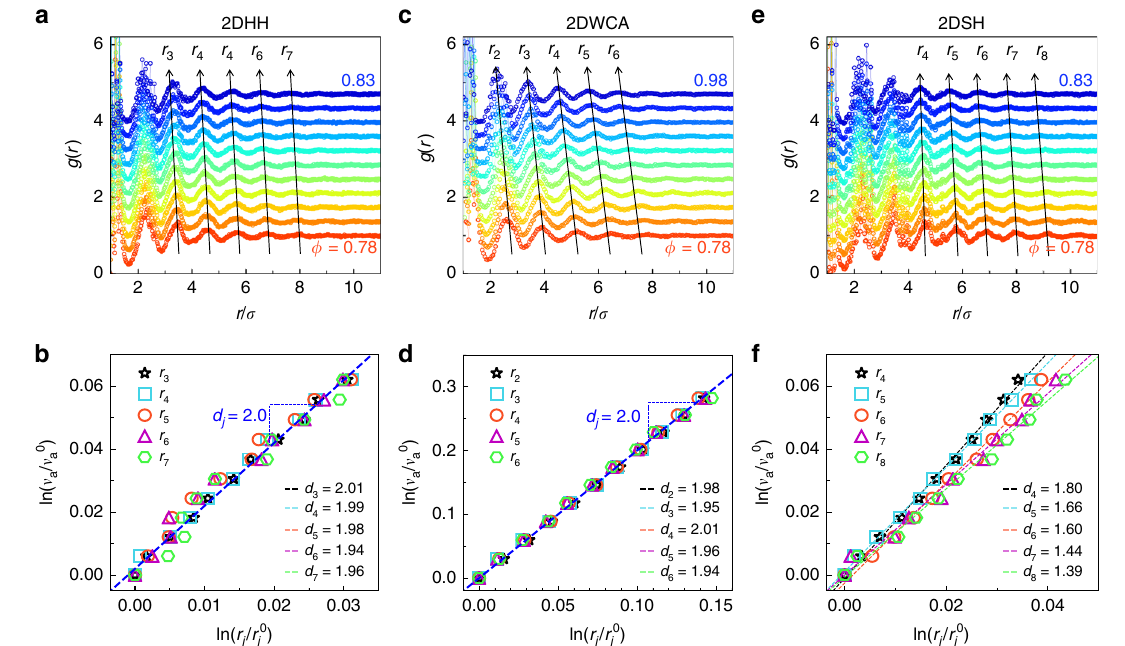
Fig. 6 Power laws v a / r d j j from the medium-range real-space structures of the glasses. a , c , e Radial distribution functions g ( r ) for 2DHH, 2DWCA and 2DSH glasses with ( η , λ ) = (0.5, 1.3), respectively. The curves are vertically shifted for clarity. The arrows show the peak positions in the medium range. / r d j measured from a , c and e , respectively. The scaling parameters v 0 b , d , f v j a glasses and d j ≃ D for 2DHH and 2DWCA